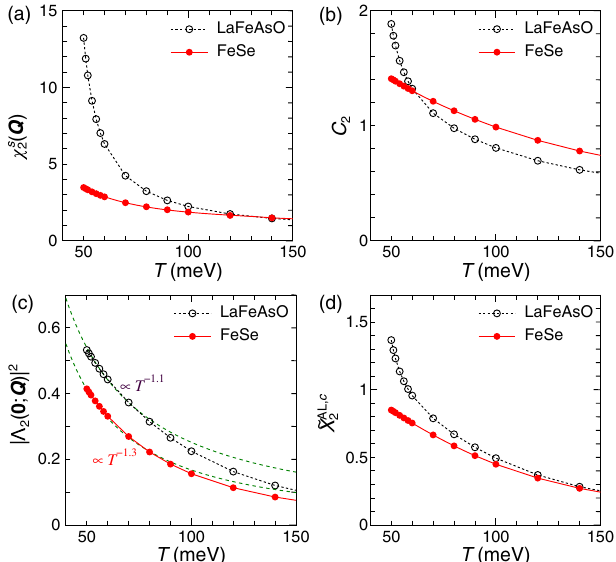
P 2 as χ s q Þ 2 , and (c) j Λ 2 j q 2 ð ~ X AL ;c ≡ 3 U 4 j Λ 0 ; ð 0 ; π ÞÞj 2 TC orbital 2 ð 2 . In 2 xz ~ X AL ;c 2 qualitatively agrees